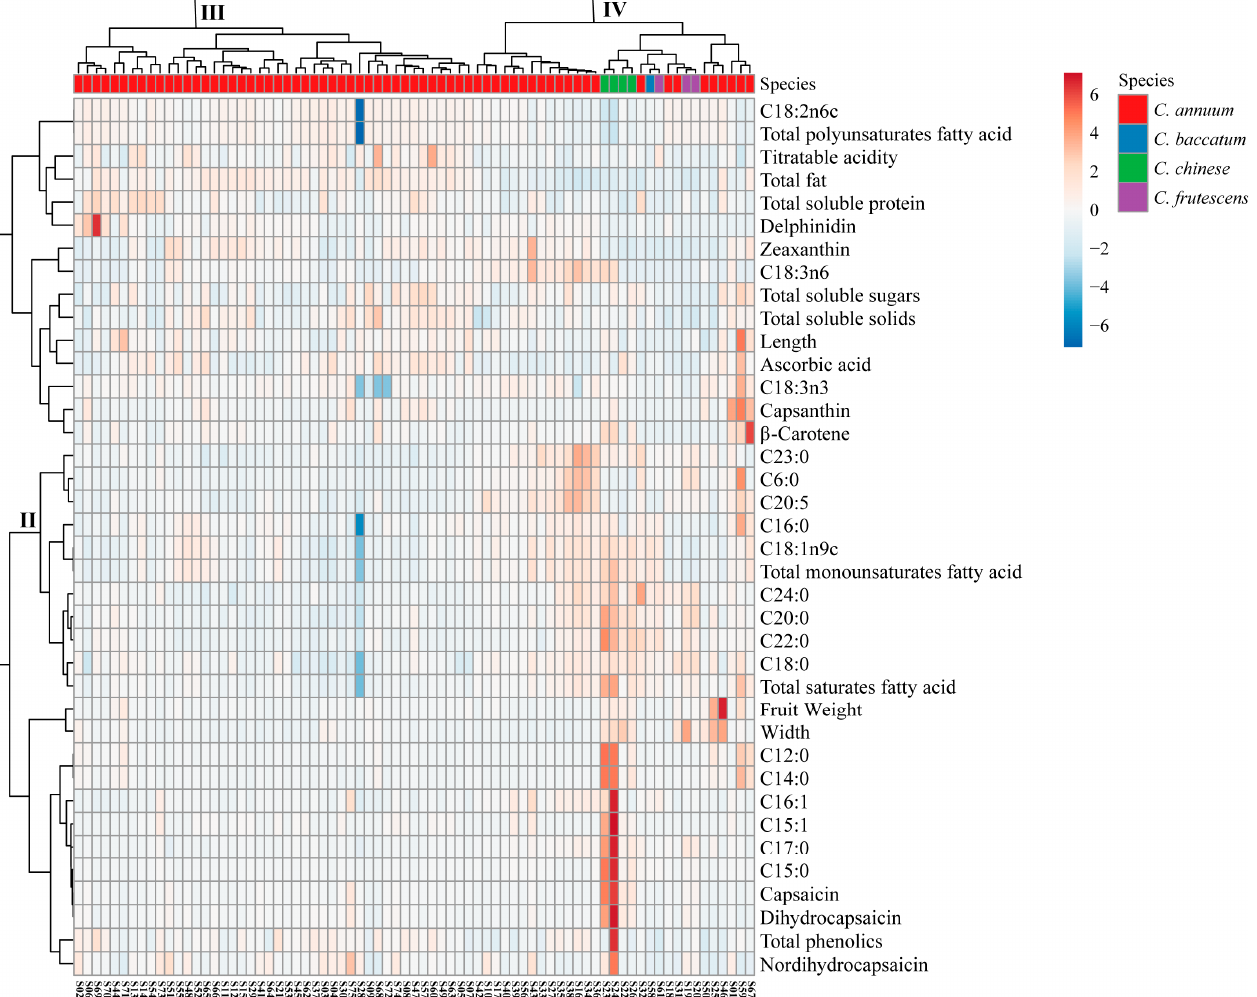
Figure 1 . Cluster heat map of quality-related indicators in the 75 pepper germplasm resources. Figure 1. Cluster heat map of quality-related indicators in the 75 pepper germplasm